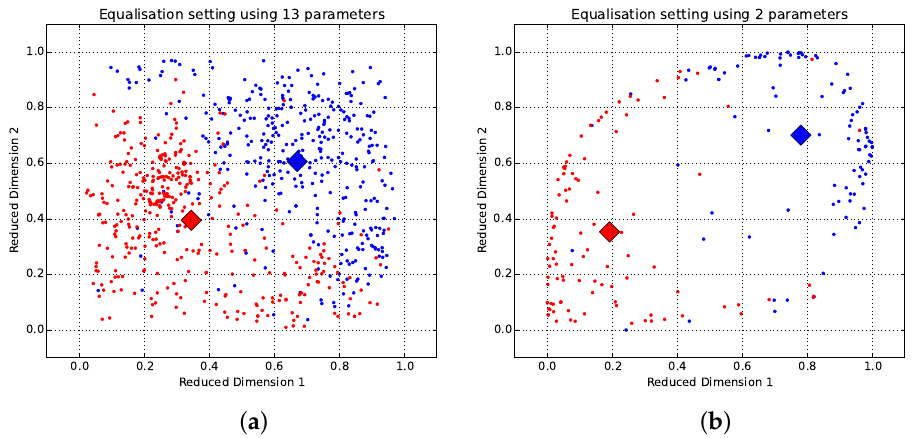
Figure 6. Equalisation settings shown in reduced dimensionality space where the figure ( a ) shows the results of users recording warm and bright samples using 13 parameters; ( b ) the results of users producing the same descriptors using a sAE-based two-dimensional equaliser. Here, diamonds represent the class centroids.